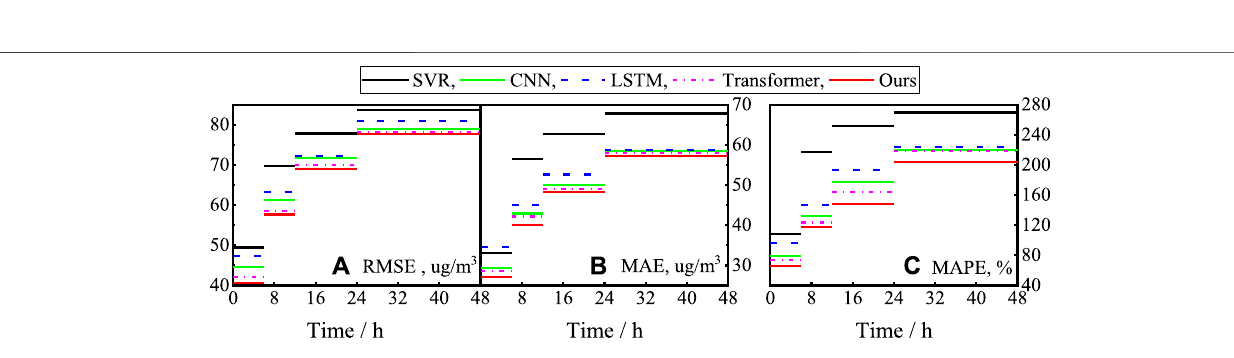
FIGURE 12 | Comparisons of different methods for multi-step prediction results for the next 48 h on Beijing dataset.